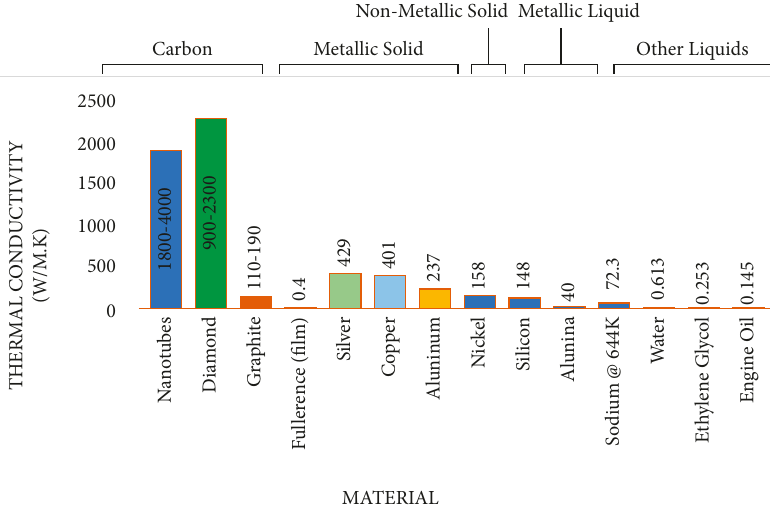
Figure 4: Thermal conductivities of various solid liquids at 300K except stated